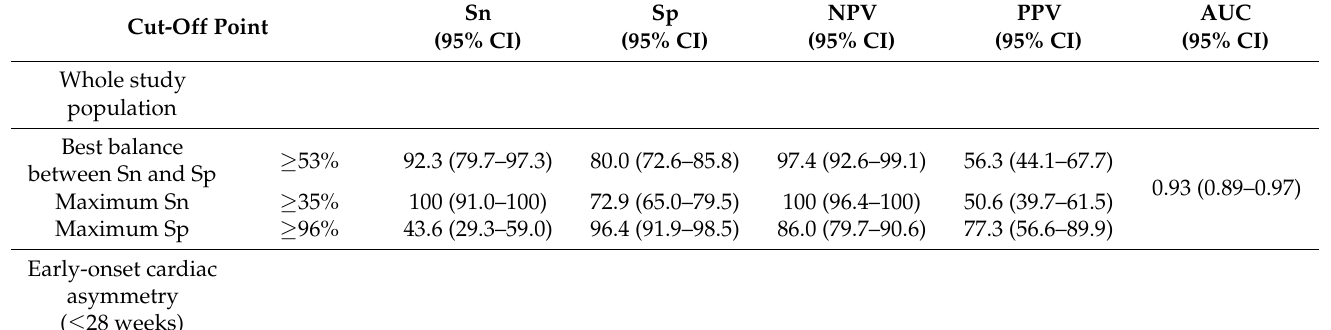
Table 3. Area under the curve (AUC), cut-off point with the best balance between specificity and sensitivity, and cut-off values of maximum sensitivity and specificity for the diagnosis of CoAo selected from the ROC curve of the multiparameter scoring system applied to the whole study population, and to the early- and late-onset cardiac asymmetry subgroups. Cut-Off